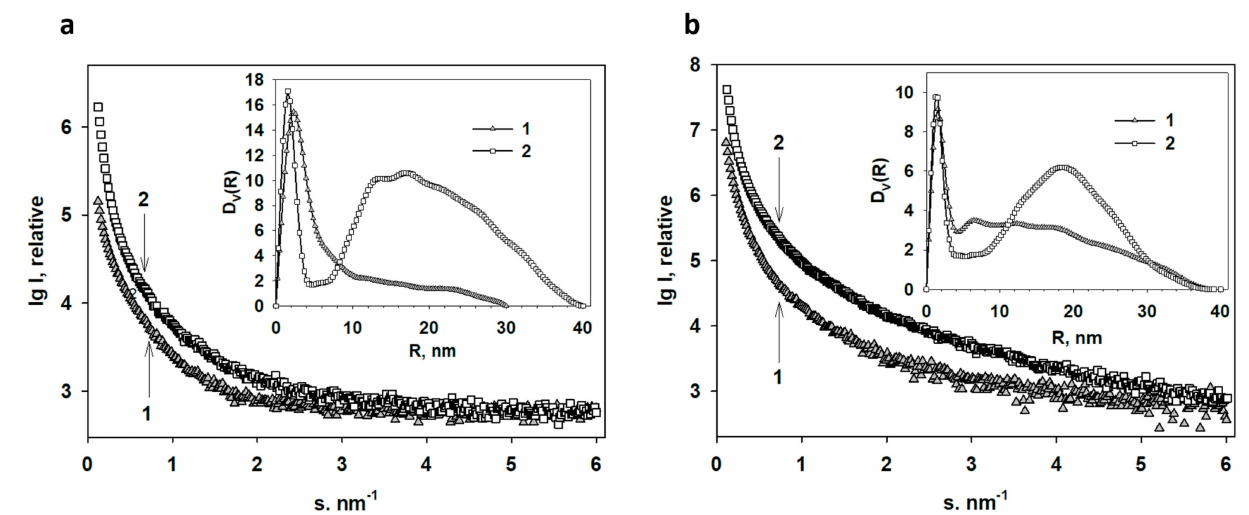
Figure 13. SAXS patterns from the nanocomposites of bacterial cellulose containing Ag nanoparticles: ( a ) experimental SAXS curves from the SBCB gel (1) and Ag NPs/SBCB gel (2). Insert: volume size distribution functions D V (R) calculated from the curves 1 and 2. ( b ) Experimental SAXS curves from the lyophilized SBCB gel (1) and lyophilized Ag NPs/SBCB gel (2). Insert: volume size distribution functions D V (R) calculated from the curves 1 and